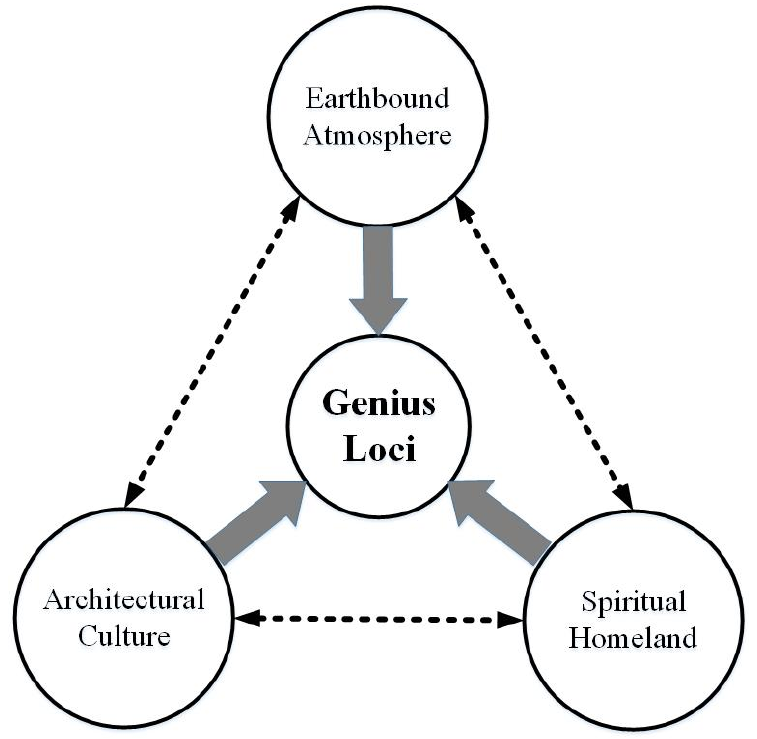
Figure 2. The conceptual framework of genius loci in an ancient village.